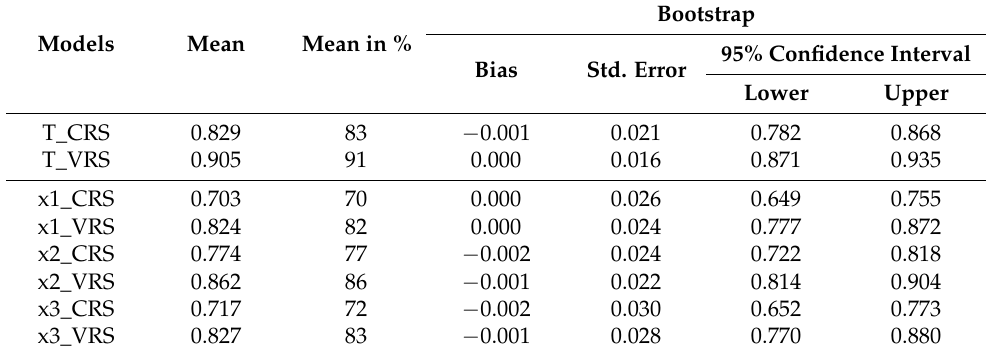
Table 4. Average efficiency values.